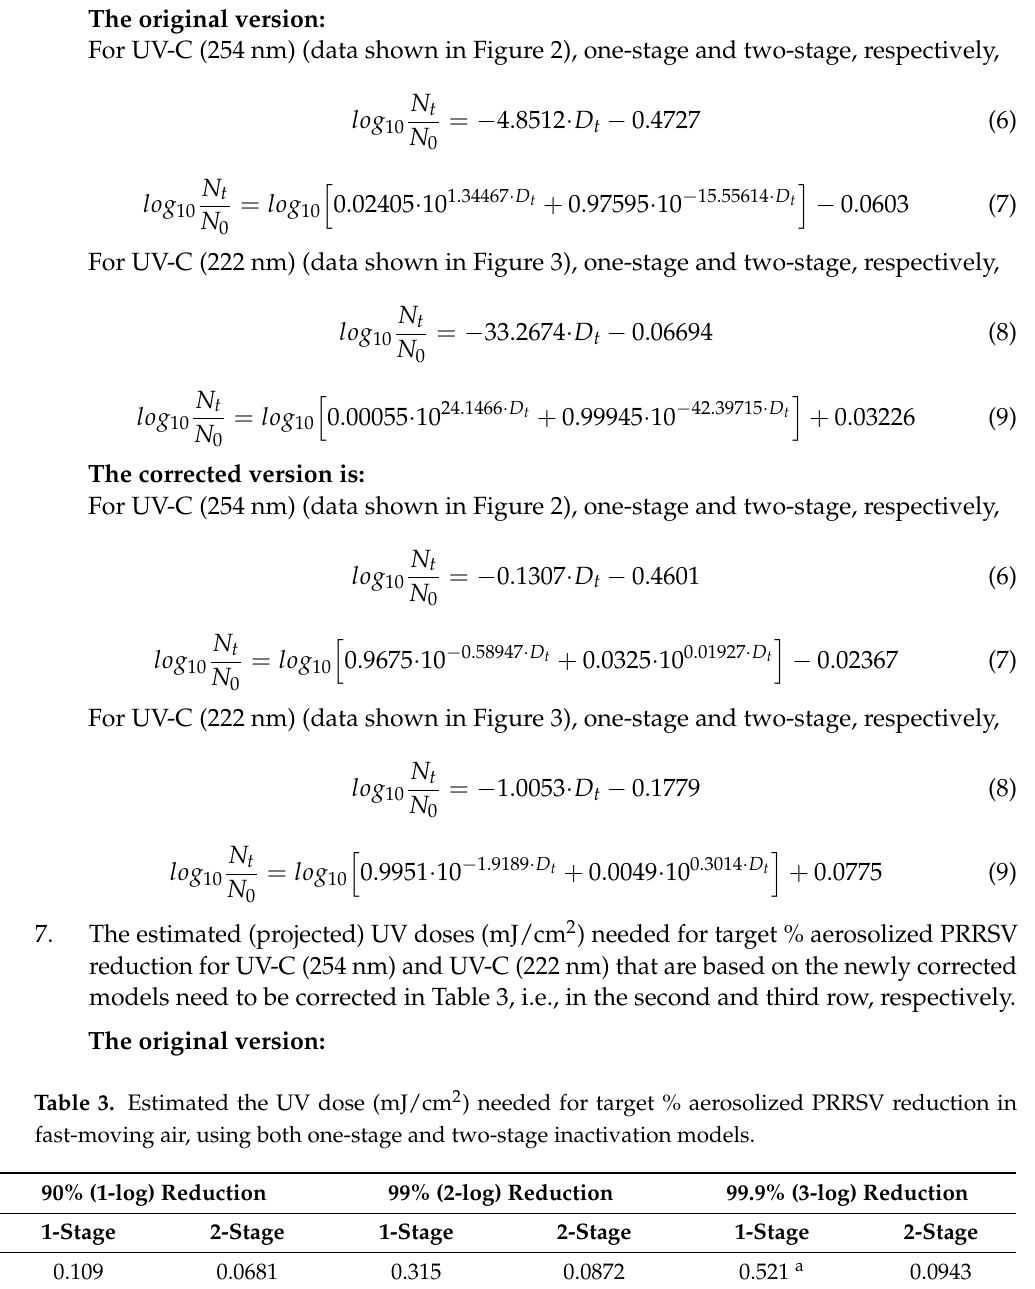
based on the corrected parameters in Table 2.